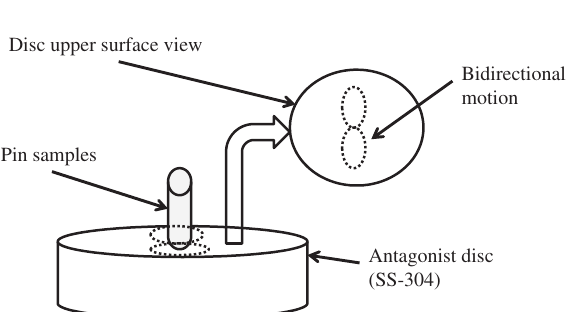
Figure 1: Block diagram of two-body abrasive dental wear.